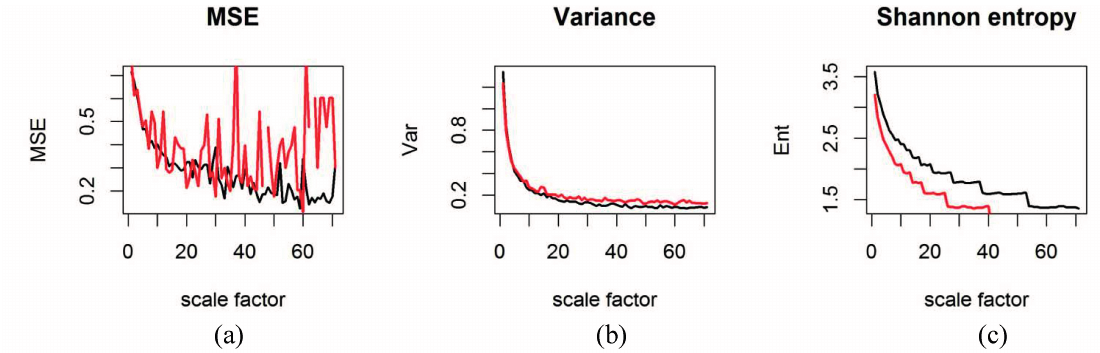
Figure 5. Sample entropy, variance and Shannon entropy for the time-series of CRUTEM4v variance-adjusted surface temperature anomaly data for grid box [8|35] with m = 3 and r = 0.3. Black = 1851–1960; Red = 1961–2014. ( a ) multi-scale sample entropy for the grid box against scale factor; ( b ) sample variance for different scale factors; ( c ) Shannon information theoretic entropy for different scale factors